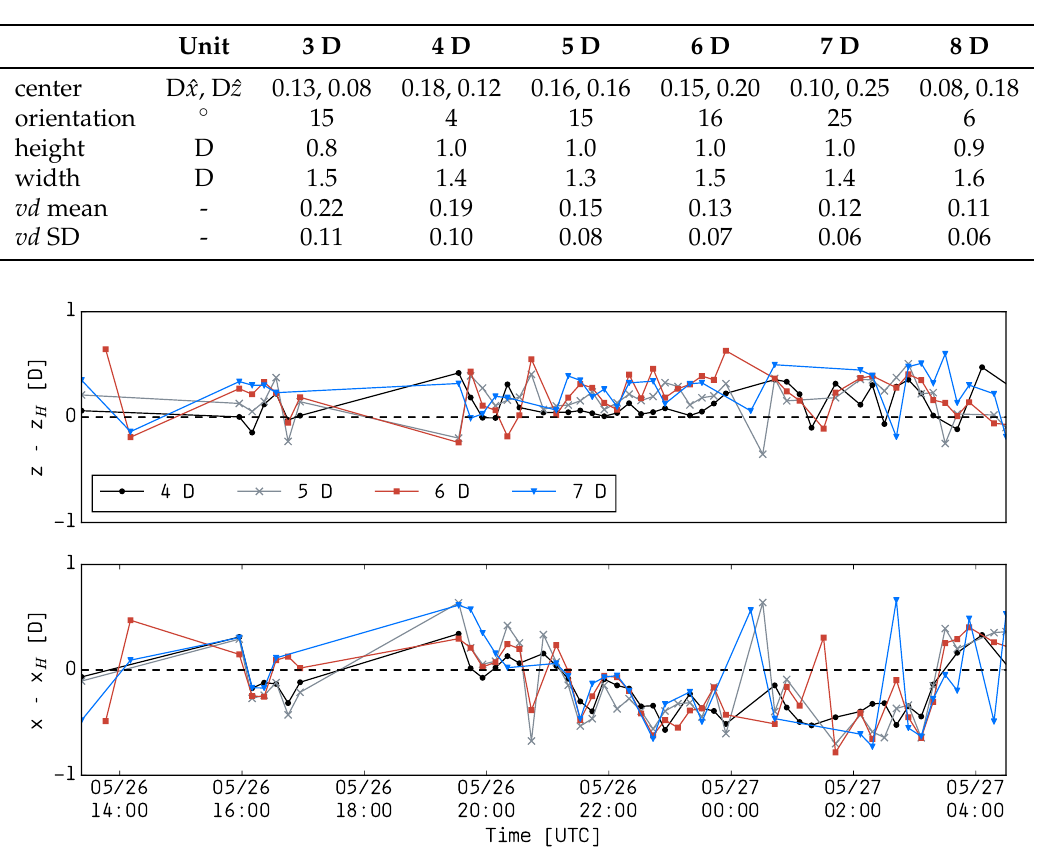
Table 2. Mean wake characteristics obtained from the field measurements and including 59 3D scans. The wake center is given as a vector in the cross-stream ( ˆ x ) and vertical directions (ˆ z ) for a coordinate system centered at the turbine hub.